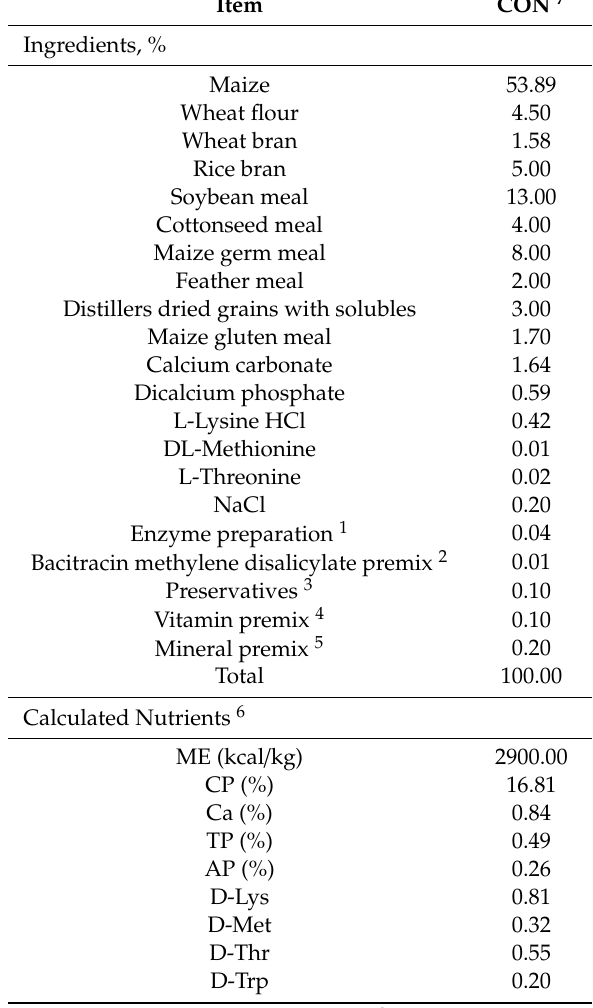
Table 1. Compositions and nutrient contents of the experiment basal diets (air dry basis, %, Experiment